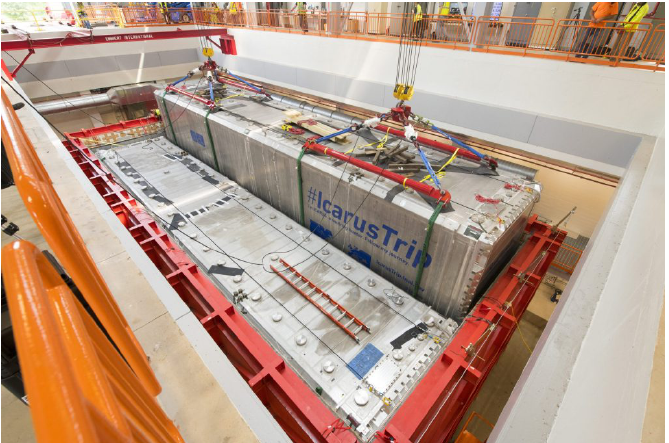
Figure 3. The ICARUS detector, operatedunderground at LNGS during the run of CNGS, was moved to Fermilab in 2018 and installed at a shallow depth to search for sterile neutrinos in the framework of the Fermilab Short Baseline Programme (SBN)